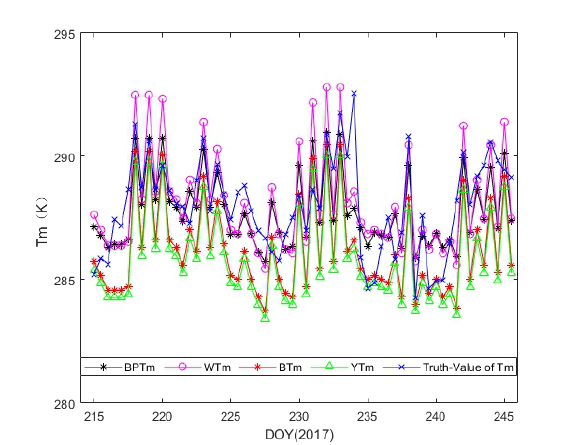
Figure 7. The analog values and true values of different models tested using radiosonde data from 2017 in Wuzhou station